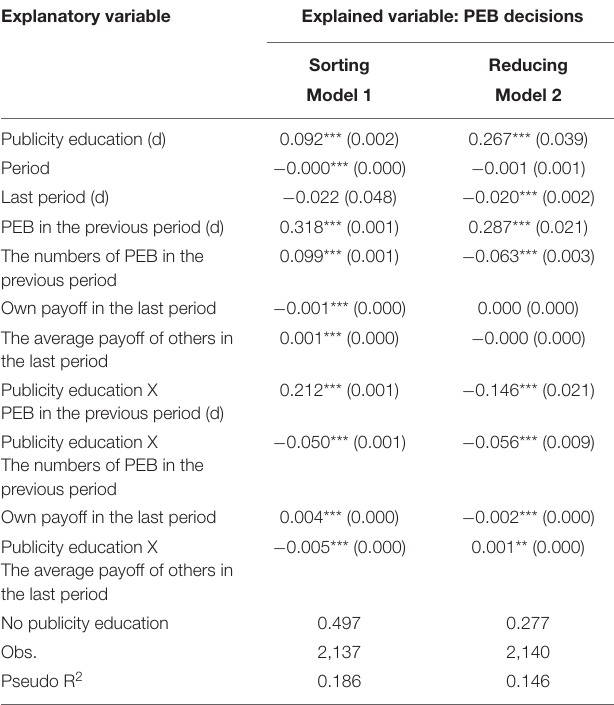
TABLE 9 | Probit regression results of publicity education on two